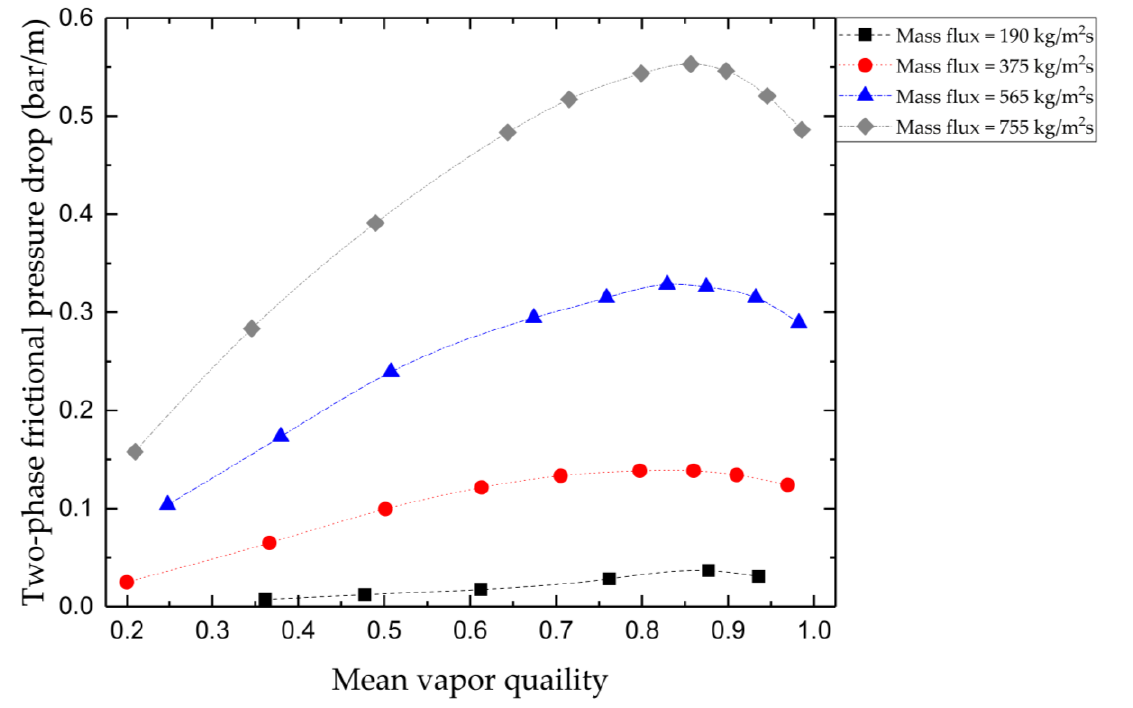
Figure 15. Two-phase HTCs as a function of vapor quality as a function of mass velocities [68].